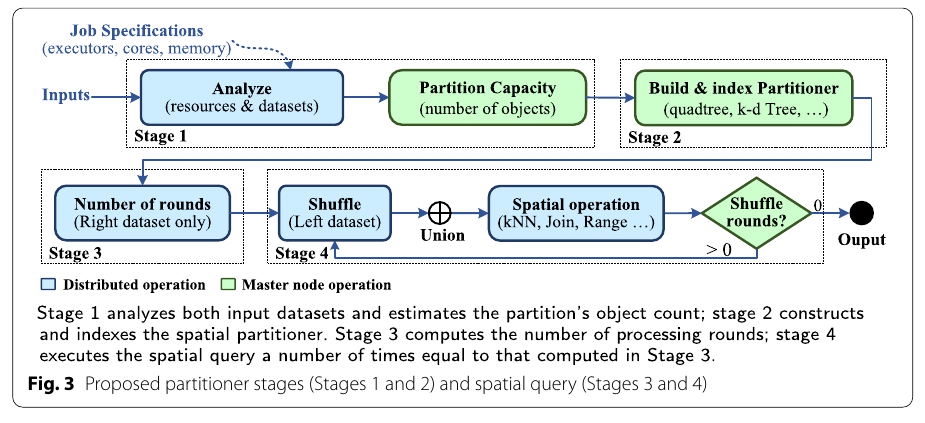
Fig. 3 Proposed partitioner stages (Stages 1 and 2) and spatial query (Stages 3 and 4)